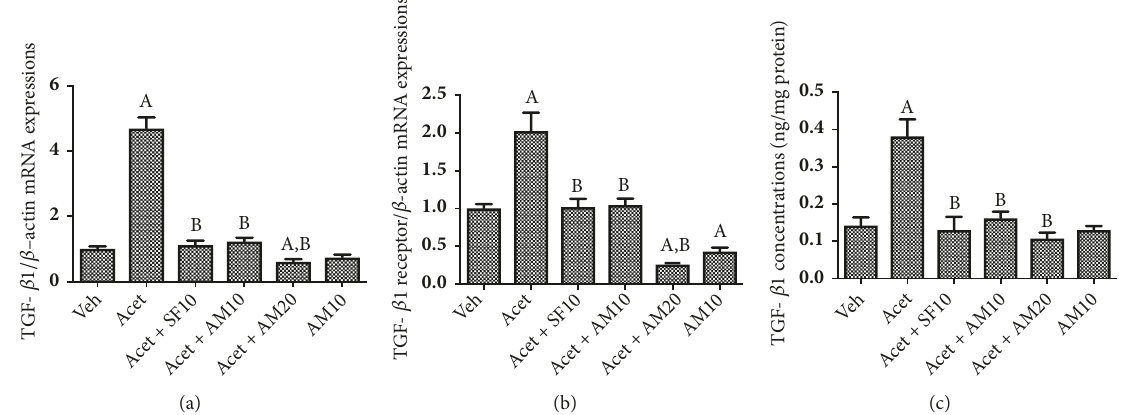
Figure7:Effectofalphamangostinin(a)mRNAexpressionofTGF 𝛽 1/ 𝛽 -actin,(b)mRNAexpressionsofTGF 𝛽 1receptor/ 𝛽 -actinexpressions, and (c) TGF 𝛽 1 concentrations after LX-2 cells were treated with alpha mangostin with or without acetaldehyde induction. Results were presented as mean ± SEM. A: p < 0.05 versus untreated group, B: p < 0.05 versus acetaldehyde group. Veh: vehicle only, Acet: acetaldehyde 100 𝜇 M, Acet+ SF10: acetaldehyde 100 𝜇 M + sorafenib 10 𝜇 M, Acet + AM10: acetaldehyde 100 𝜇 M + alpha mangostin 10 𝜇 M, Acet + AM20: